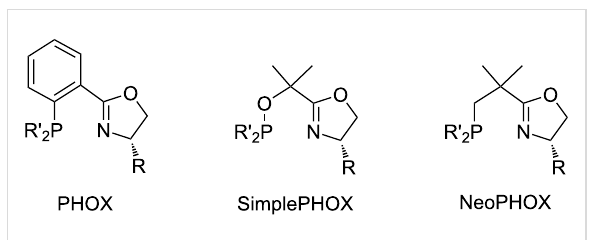
Figure 1: Structural motifs of phospinooxazoline